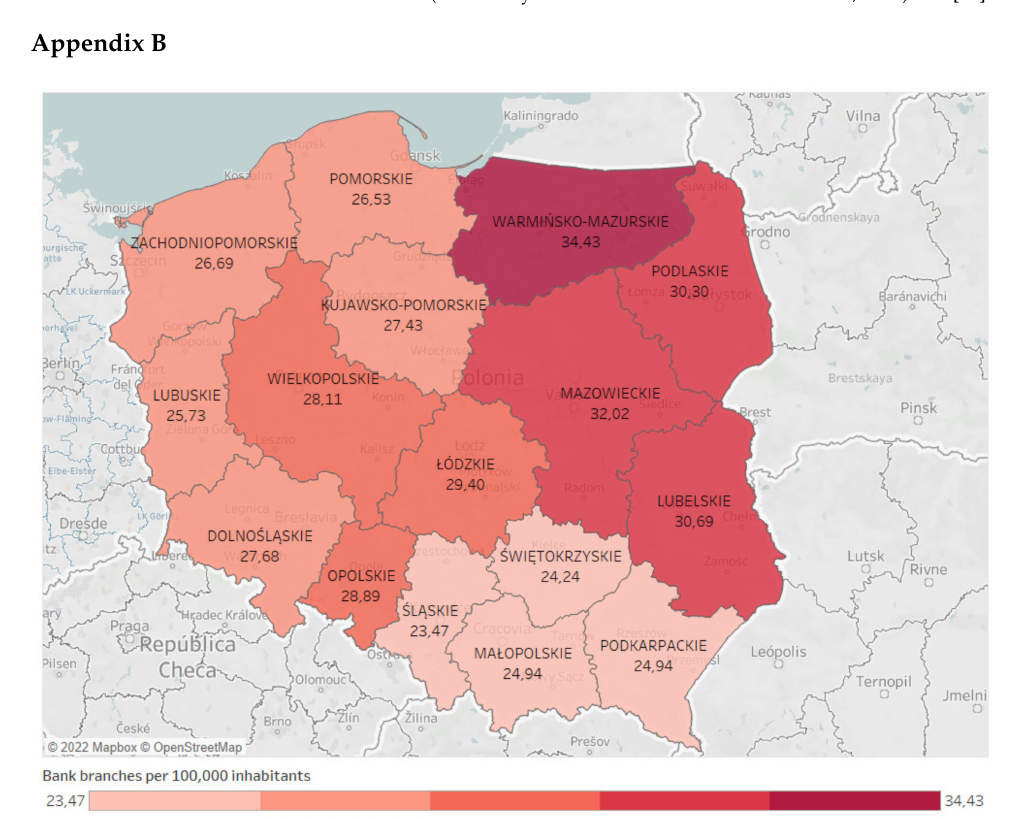
Figure A1. Voivodeships with the fewest bank branches per 100,000 inhabitants. Source: Own elaboration based on data from Table A1 and Tableau Desktop Professional